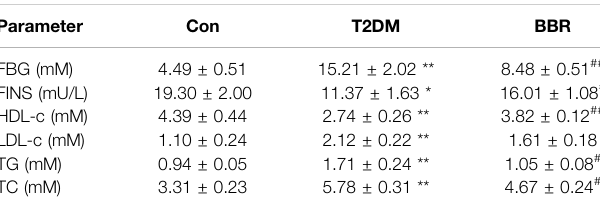
TABLE 2 | Effect of BBR on the serum biochemical parameters of T2DM C57BL/ 6J mice.